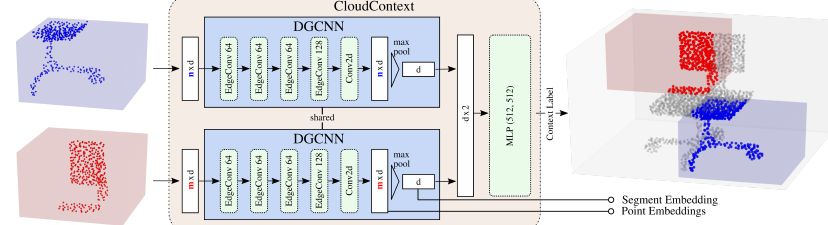
Figure 9. DGCNN network architecture for unsupervised context prediction for point